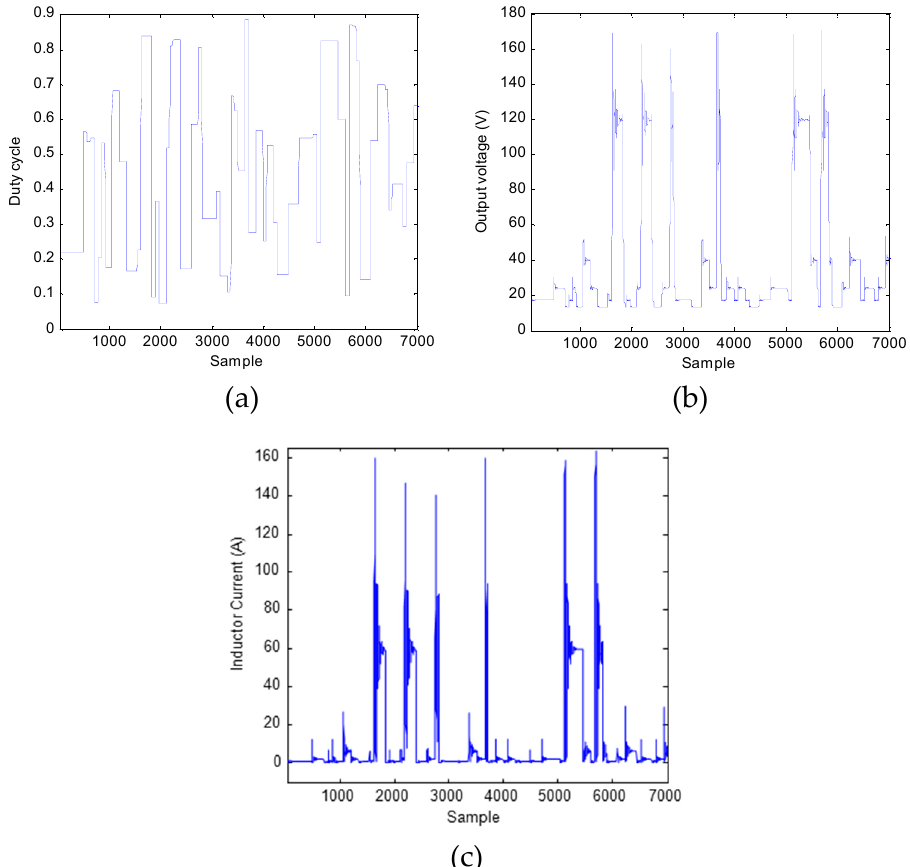
Figure 3. ( a ) The APRBS signal (duty cycle) for identification of boost converter; ( b ) waveform of converter output voltage obtained by applying the APRBS signal; and ( c ) waveform of inductor current obtained by applying the APRBS signal.